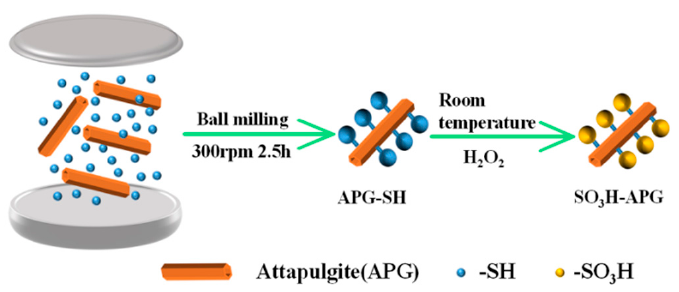
Figure 8. Preparation route of SO 3 H-APG catalyst.